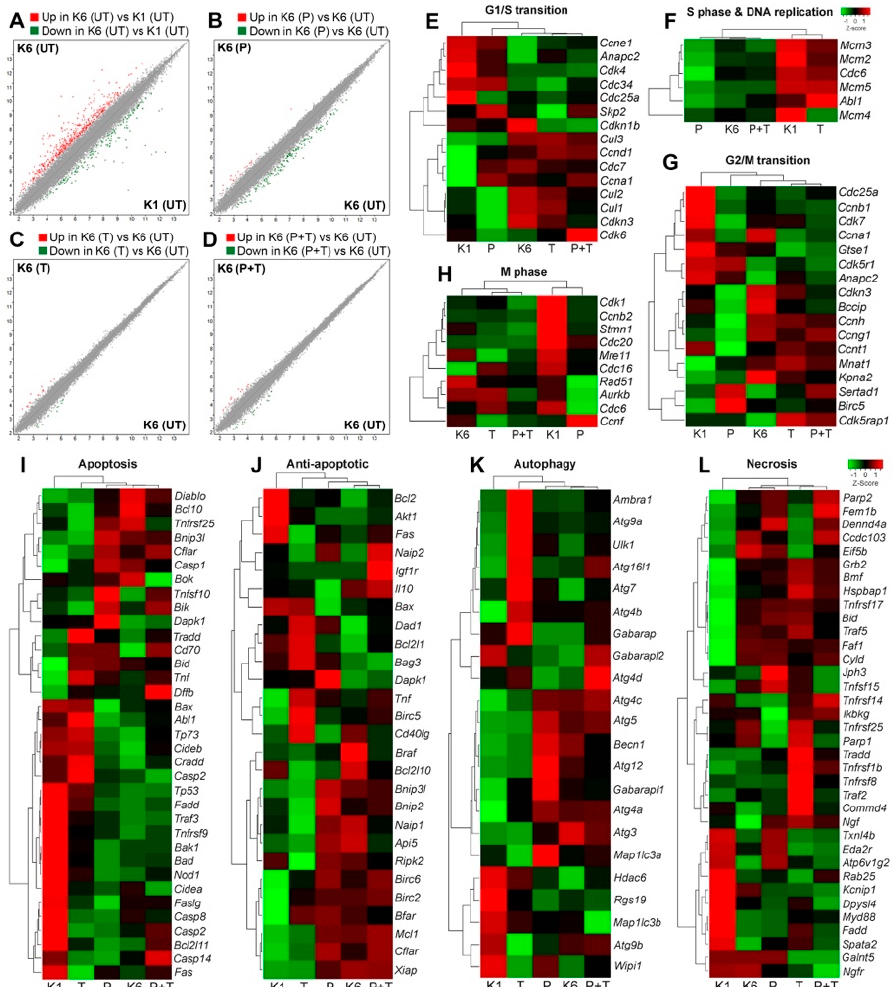
Figure 5. The effects of pertuzumab on gene expression profile of HER2 overexpressing cells. The whole transcript levels were evaluated by microarray for untreated CHO-K1, untreated CHO-K6 and CHO-K6 treated with 10 µ g/mL pertuzumab (P), 10 µ g/mL trastuzumab (T), and their combination (P+T) for 24 h. ( A – D ) Scatter plot showing the whole gene expression profile of ( A ) untreated CHO-K6 (K6) vs. untreated CHO-K1 (K1) cell lines, ( B ) pertuzumab treated vs. untreated CHO-K6 cells, ( C ) trastuzumab treated vs. untreated CHO-K6 cells and ( D ) CHO-K6 cells treated with the combination of the monoclonal antibodies vs. untreated cells. The values with a minimum of two-fold change are illustrated in red (upregulated) and green (downregulated) dots. ( E – L ) Hierarchal heatmap illustrating z-score expression of selected marker genes for ( E ) G1/S transition, ( F ) S phase and DNA replication, ( G ) G2/M transition, ( H ) M phase of cell cycle, ( I ) apoptosis, ( J ) anti-apoptosis, ( K ) autophagy, and ( L ) necrosis.